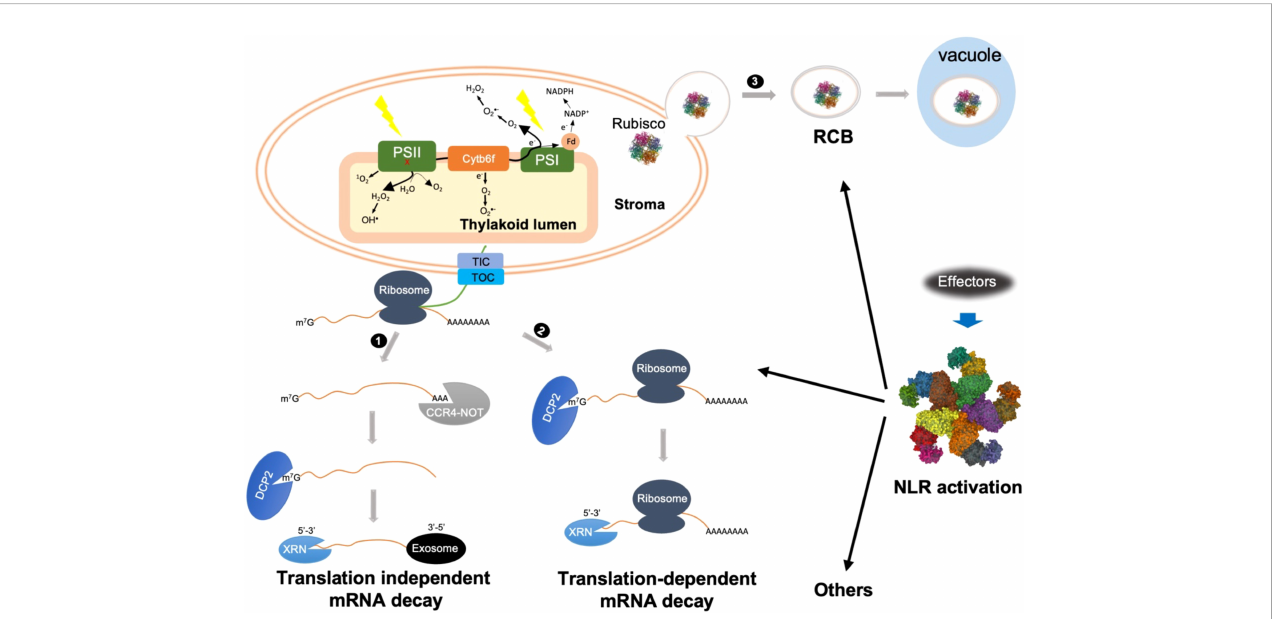
FIGURE 1 Schematic representations of possible cytoplasmic regulatory mechanisms of cROS accumulation during ETI. ETI activation might trigger both translation-dependent and -independent mRNA decay to actively degrade photosynthetic transcripts. 1) Translation-independent mRNA decay is initiated with CCR4-NOT complex-mediated deadenylation. After 5 ’ decapping, further degradation is carried out by either 5 ’ -3 ’ or 3 ’ -5 ’ decay mediated by XRN or exosome, respectively. 2) Translation-dependent mRNA decay can only occur through XRN-mediated 5 ’ -3 ’ decay. Bulk mRNA decay of photosynthetic transcripts impairs the repair or turnover cycle of photosynthetic complexes, mainly PSII, resulting in 1 O 2 and OH (cid:129) production from damaged PSII, indicated by a red x. 3) NLR activation triggers autophagy-dependent formation of Rubisco-containing body (RCB) through which Rubisco as well as other stroma proteins are delivered into the vacuole for degradation. Removal of Rubisco may cause stroma overreduction and/or reduce O 2 consumption, which facilitates electron leakage from PSI as well as cytochrome b 6 f complex (Cyt b 6 f) to O 2 , resulting in O 2 (cid:129) - formation at both stroma side and inside thylakoid lumen. Other cytoplasmic mechanisms might also contribute to cROS accumulation during